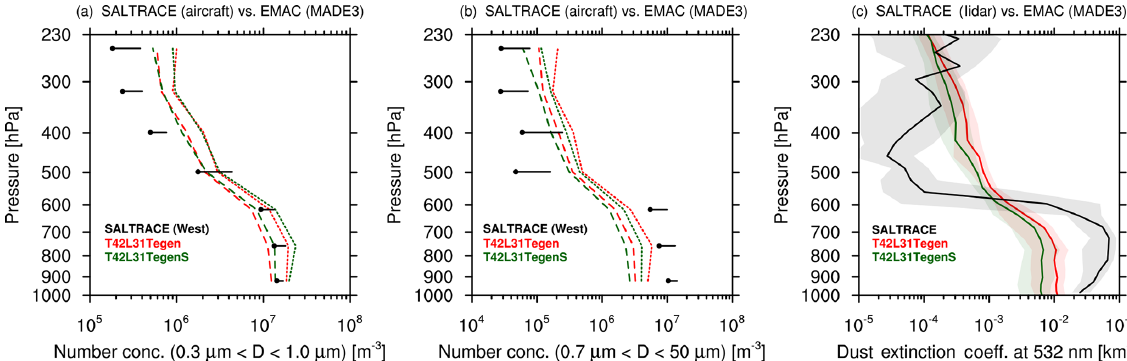
Figure 6. Similar to Fig. 5 but comparing the T42L31Tegen (red) and the T42L31TegenS (green) model setups with SALTRACE observations (black), i.e. the reference model setup and a setup with different assumptions for the size distribution of emitted dust. For the T42L31TegenS setup, the dust size distribution calculated from measurements during the SAMUM-1 campaign is